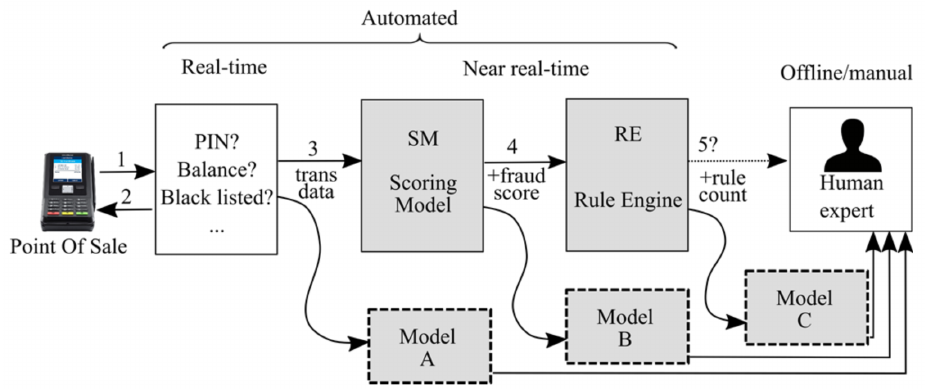
Figure 4. Diagram of the baseline (production) system and possible inclusion positions of a newly developed